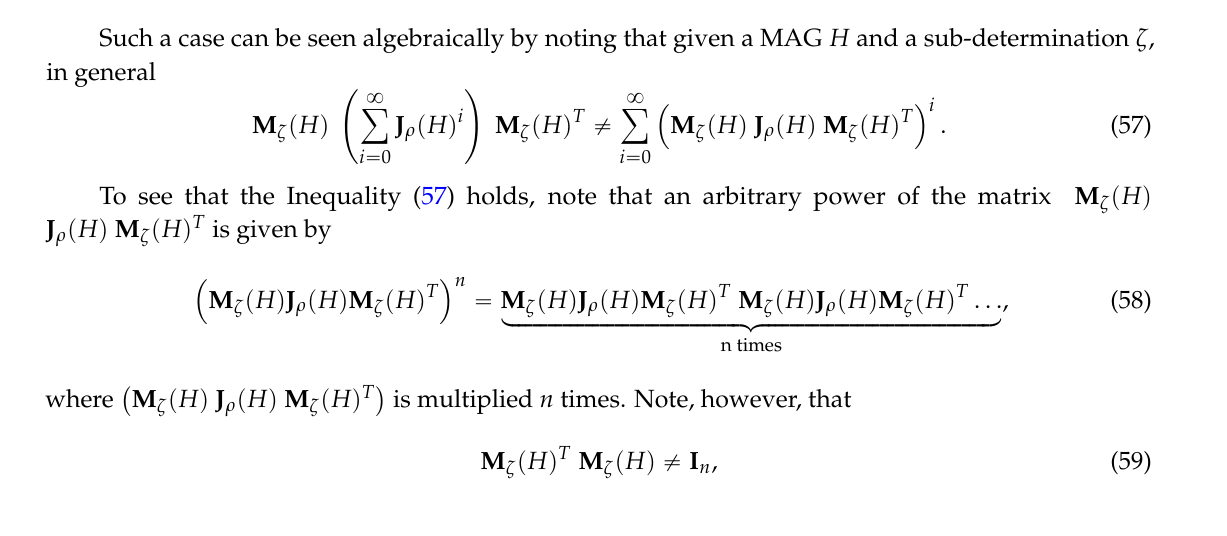
Figure 6. MAG R and its sub-determined